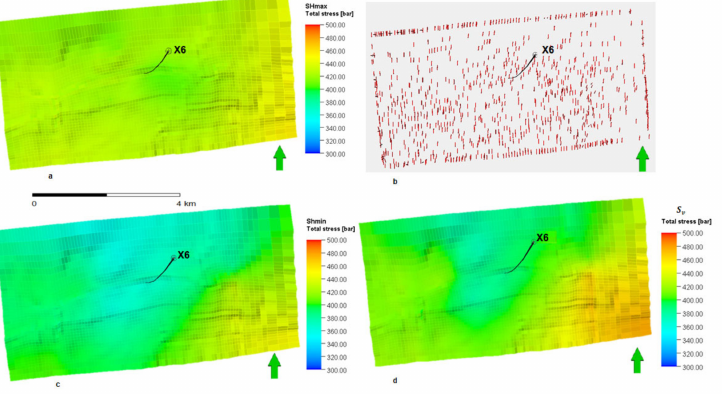
Figure 14. Map view of the computed principal stresses on top of the reservoir. ( a ) = magnitude of the maximum horizontal stress ( S Hmax